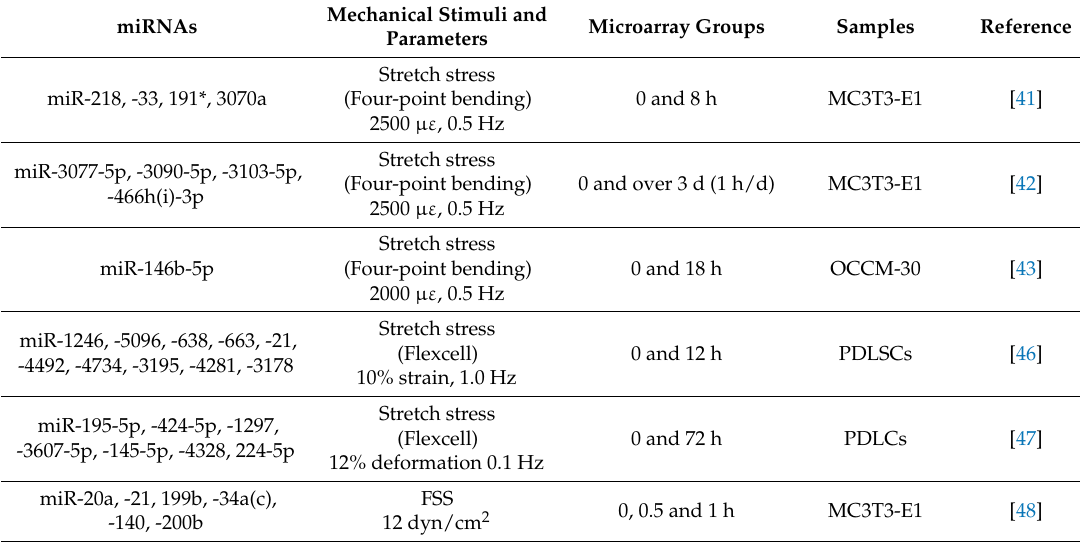
Mechanosensitive miRNAs screened by microarray are putatively involved in osteogenic differentiation. Mechanical Stimuli and Microarray Groups Samples miRNAs Parameters